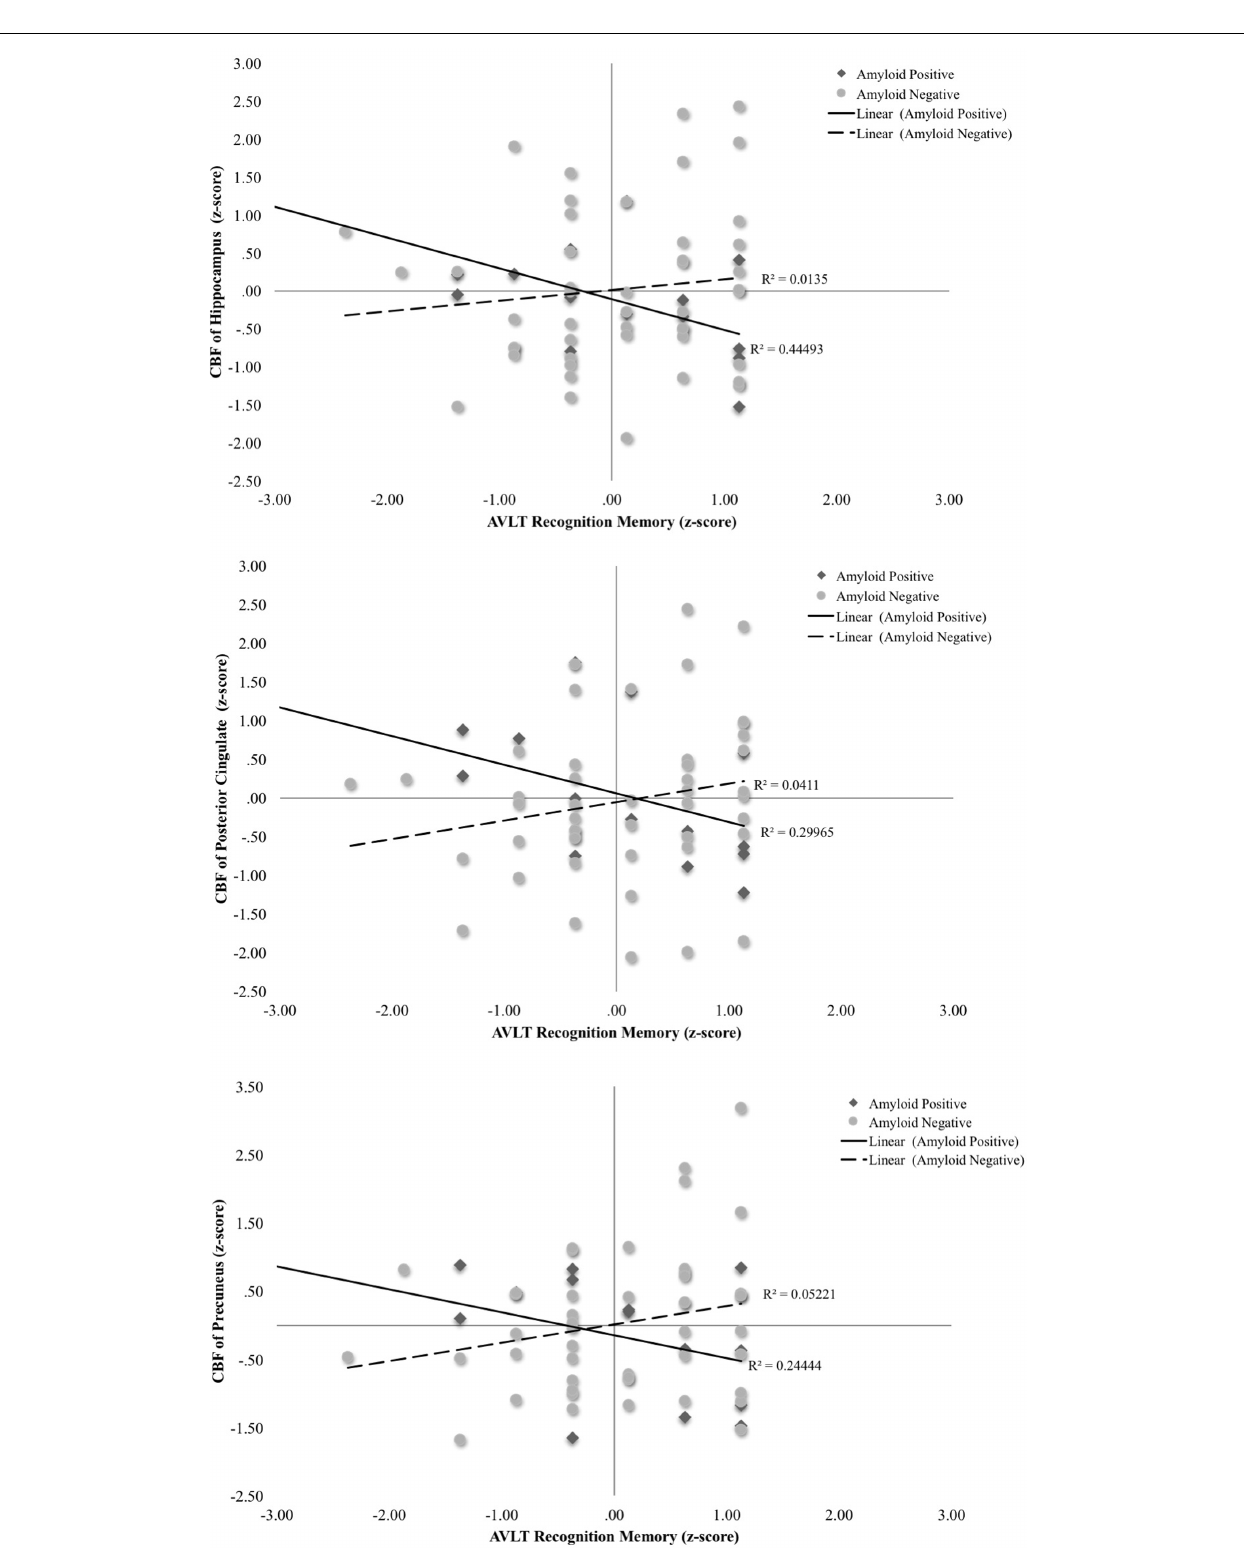
Frontiers in Aging Neuroscience |